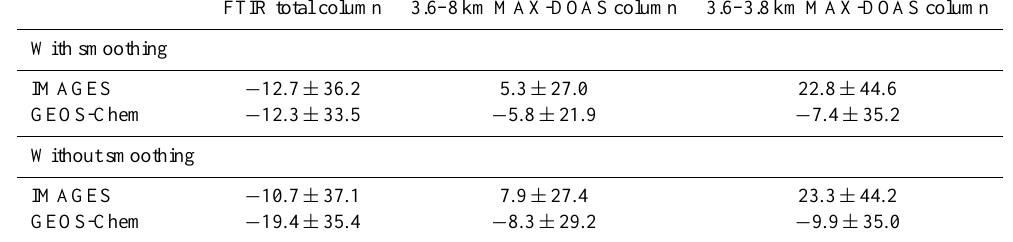
Table 4. Mean fractional differences (in % ± 1 σ ), calculated on the basis of daily-mean values, between the FTIR and MAX-DOAS HCHO columns (and near-surface concentration) and the CTM outputs for the July 2010–December 2012 time period above Jungfraujoch. These mean fractional differences are given for the comparisons involving the CTM profiles with and without smoothing by the FTIR and MAX- DOAS averaging